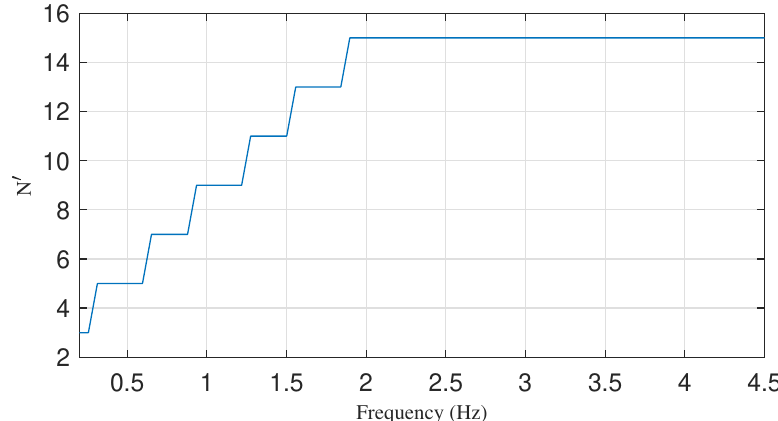
Figure 6. The value of N (cid:48) as a function of frequency.